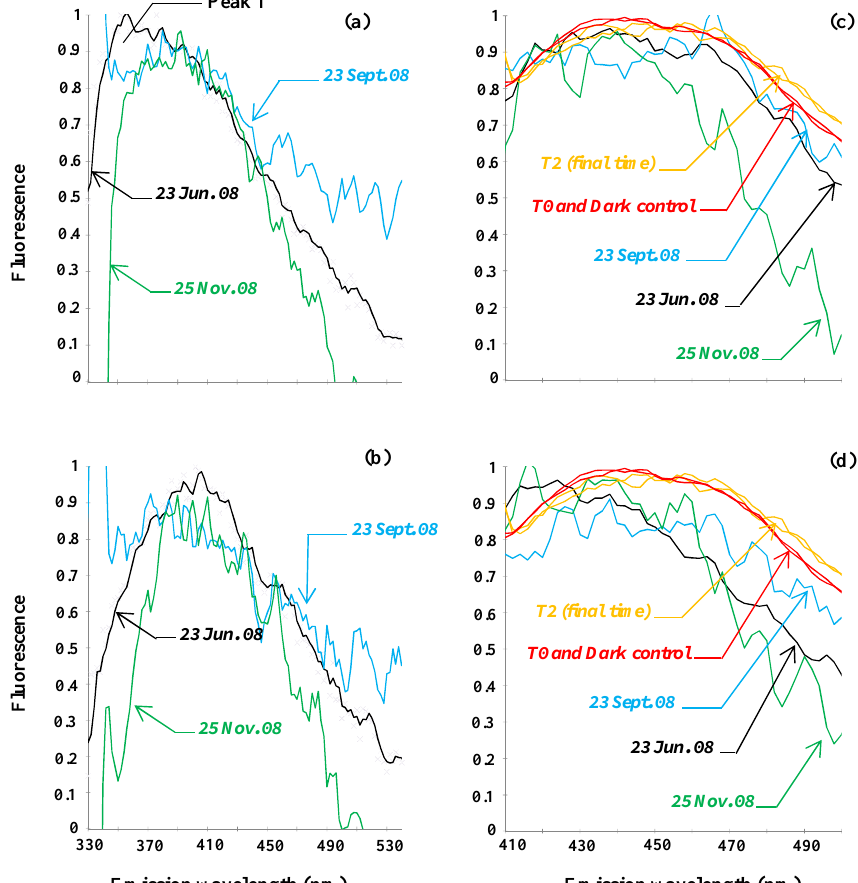
Fig. 6. Normalized emission spectra of peak M at Ex = 300nm ( a and b ) and peak C at Ex = 350nm ( c and d ) acquired at SOFCOM station on 23 June (Rhˆone plume intrusion sample, black solid line), 23 September (photobleached sample, blue solid line) and 25 November 2008 (well mixed sample, green solid line) at 2 (upper panel) and 5m (bottom panel) depths. Normalized emission spectra of peak C determined at T0, dark control (red solid line) and T2 (duplicate, orange solid line) of the irradiation experiment performed on Rhˆone River sample collected on 7 February 2009 at 2m depth were also plotted on both panels (c) and (d) . These emission spectra were normalized to the maximum emission intensity in the range 380–400nm for the peak M and 430–450 nm for the peak C. These spectra were smoothed by a moving average order 3 which imposes a red shifted of